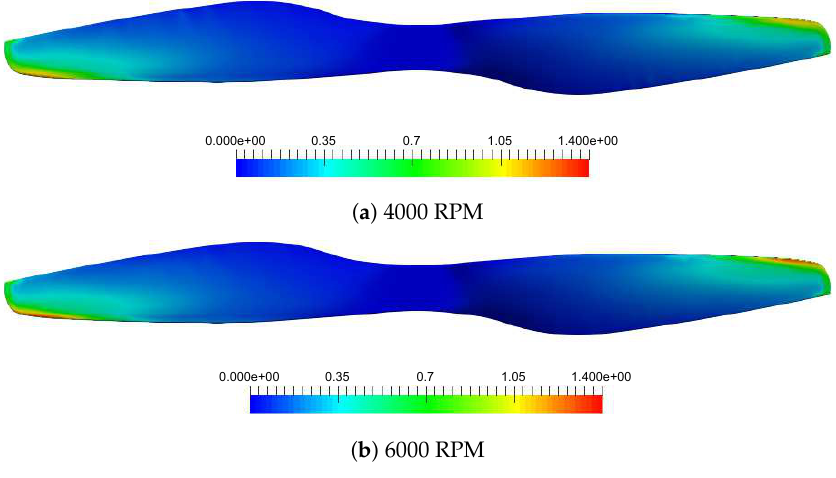
Figure 12. C p Contours from CFD simulations.